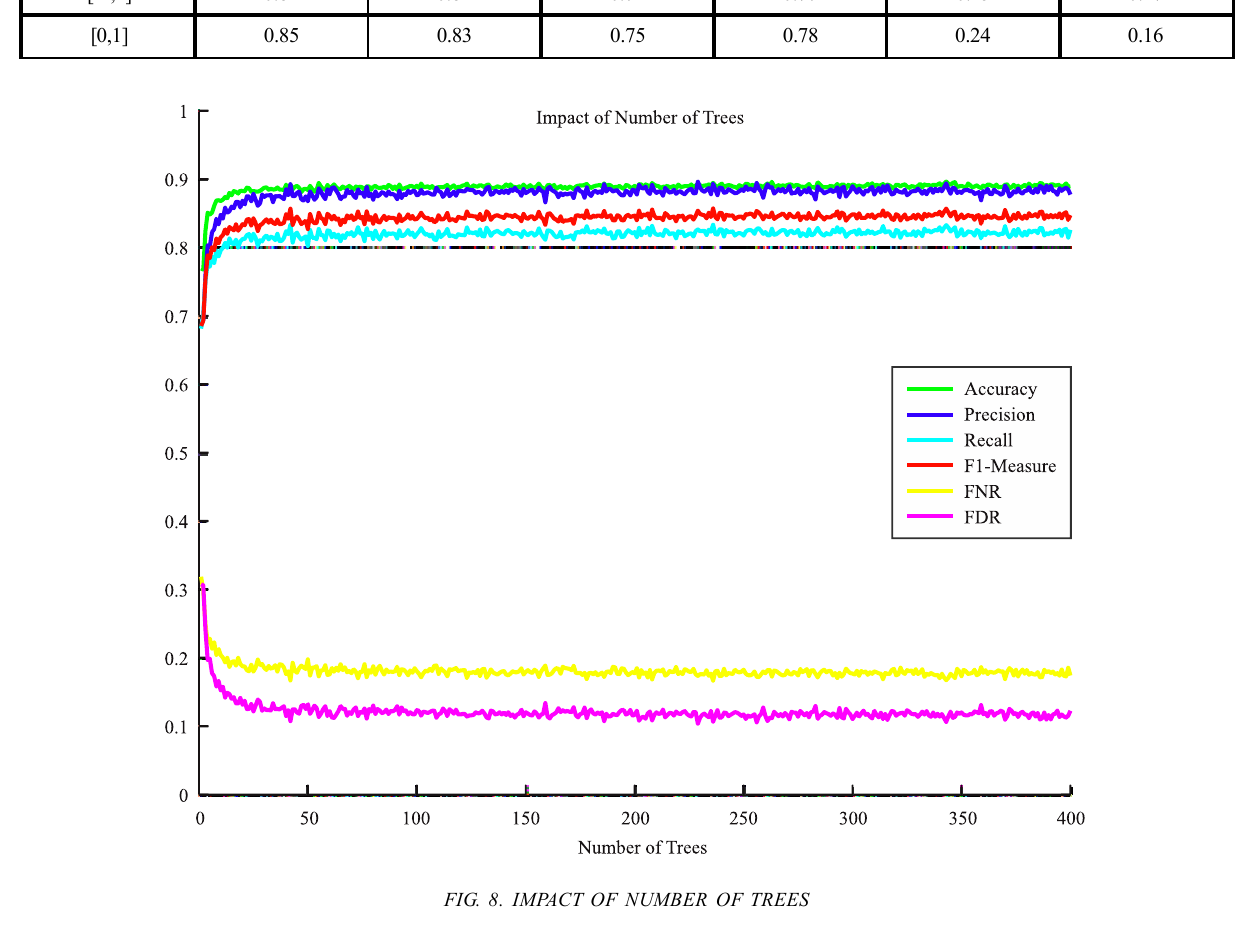
FIG. 8. IMPACT OF NUMBER OF TREES